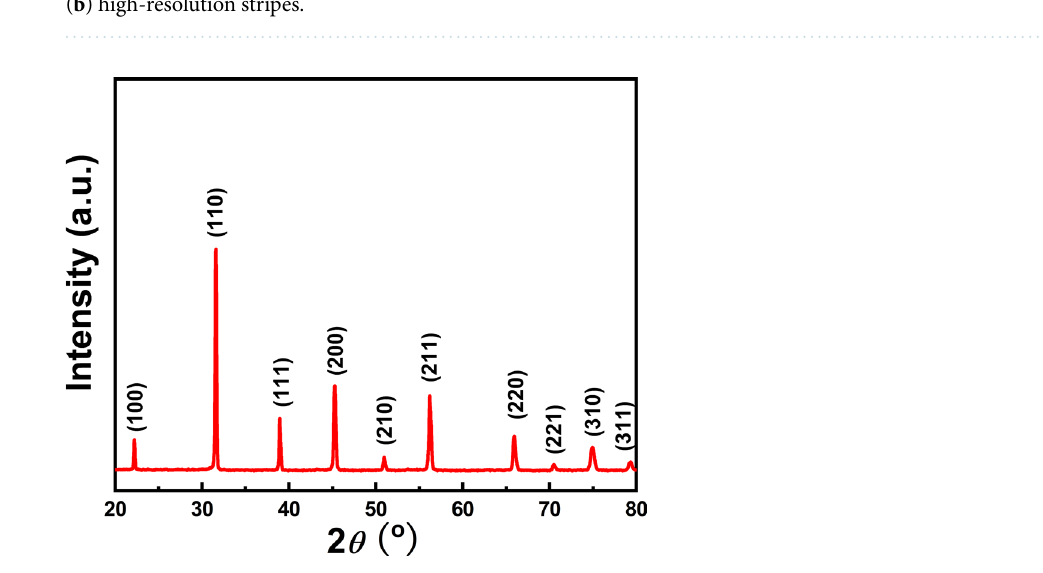
Figure 5. XRD patterns of MSGH derived BCZT ceramic sintered at 1400